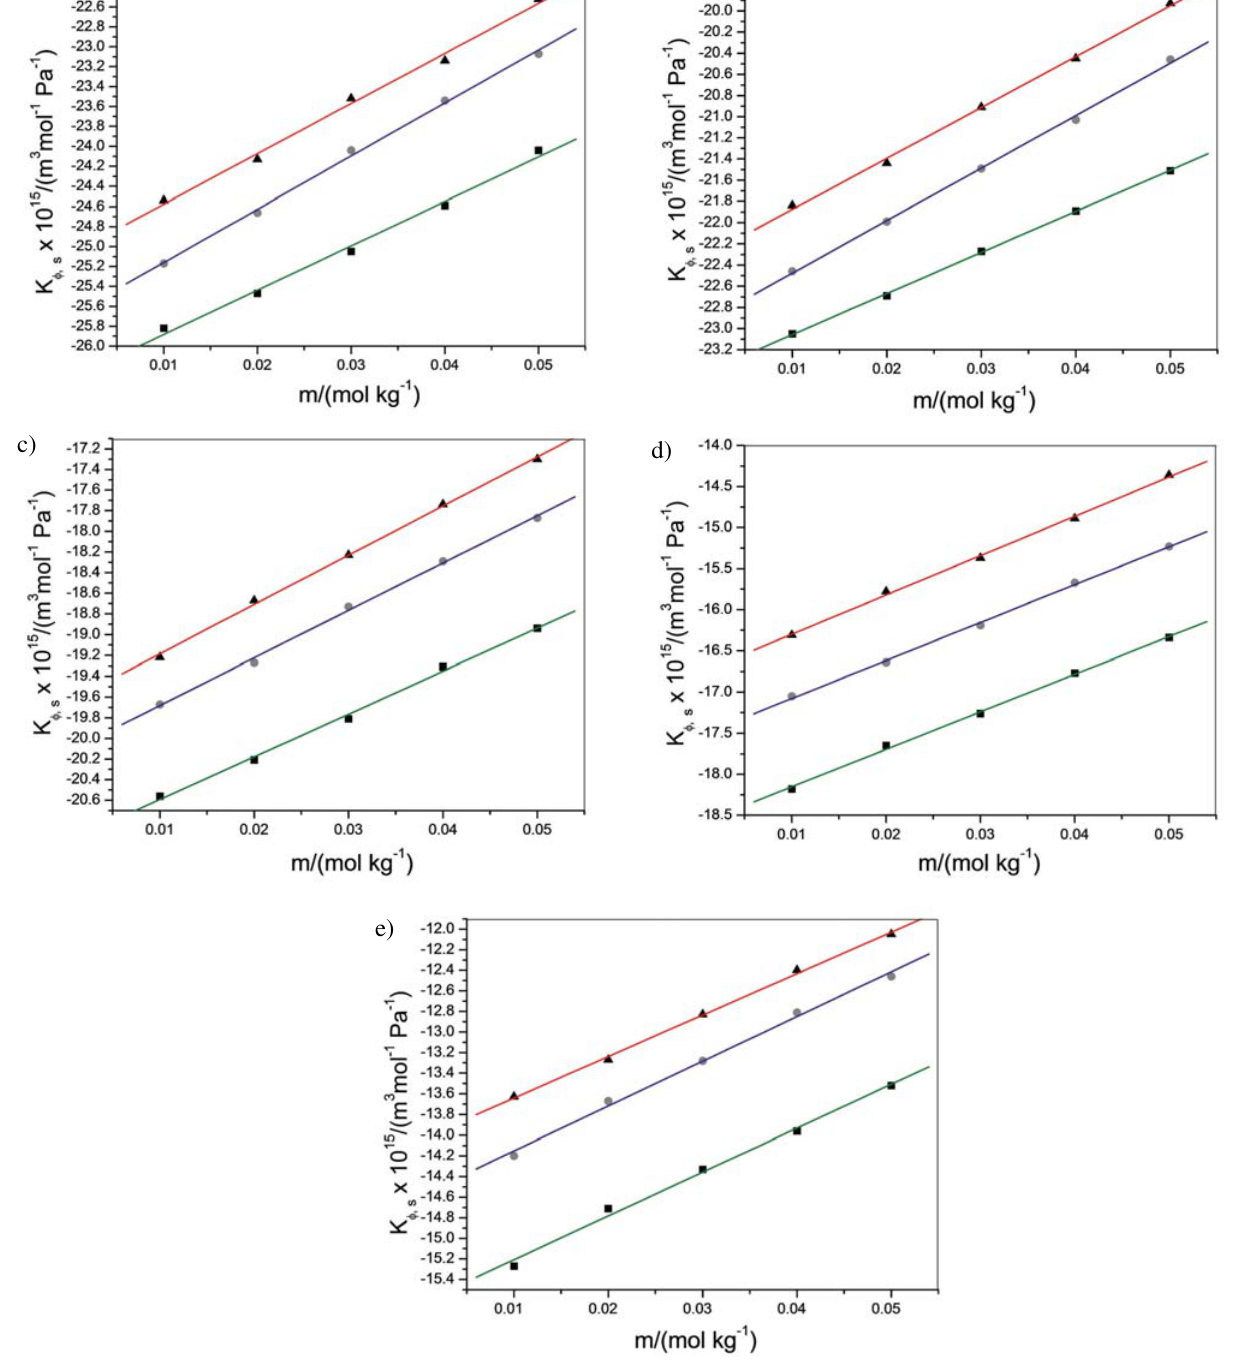
Figure 2. Variation of apparent molar isentropic compressibility versus molality of Asp in aqueous and aqueous + PD solutions: (a) water, (b) 5% PD, (c) 10% PD, (d) 15% PD and (e) 20% PD at temperatures, T/K = 298.15 ( (cid:2) ); 303.15 ( (cid:3) ); 308.15 ( (cid:2) Rani et al.: Interactions of L-Aspartic Acid with Aqueous Solution ...